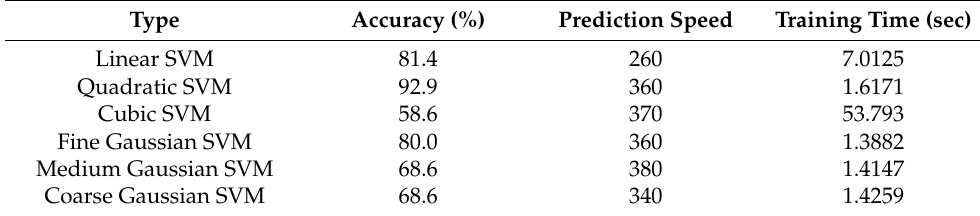
Table 4. SVM 1 DGA classification